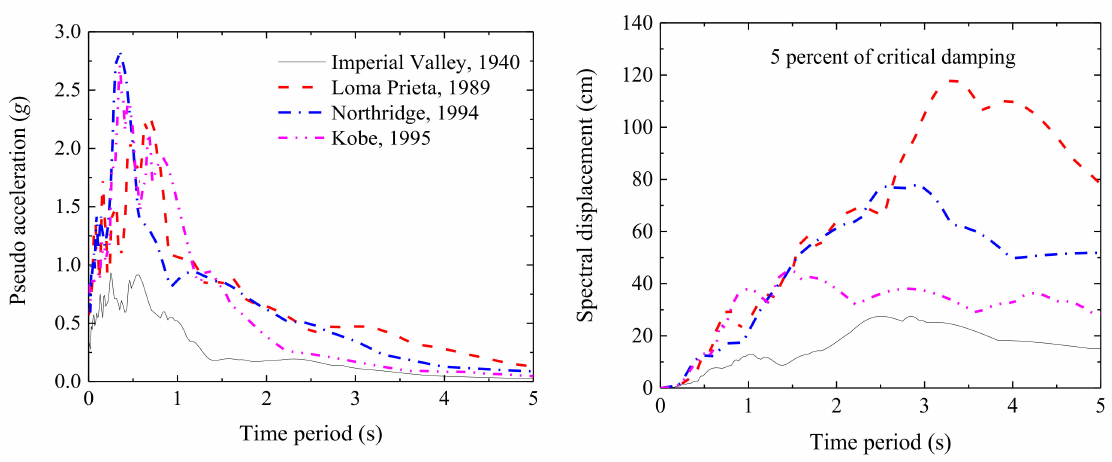
Figure 5. Spectrum response, for 5% of critical damping, of earthquake events considered in the current